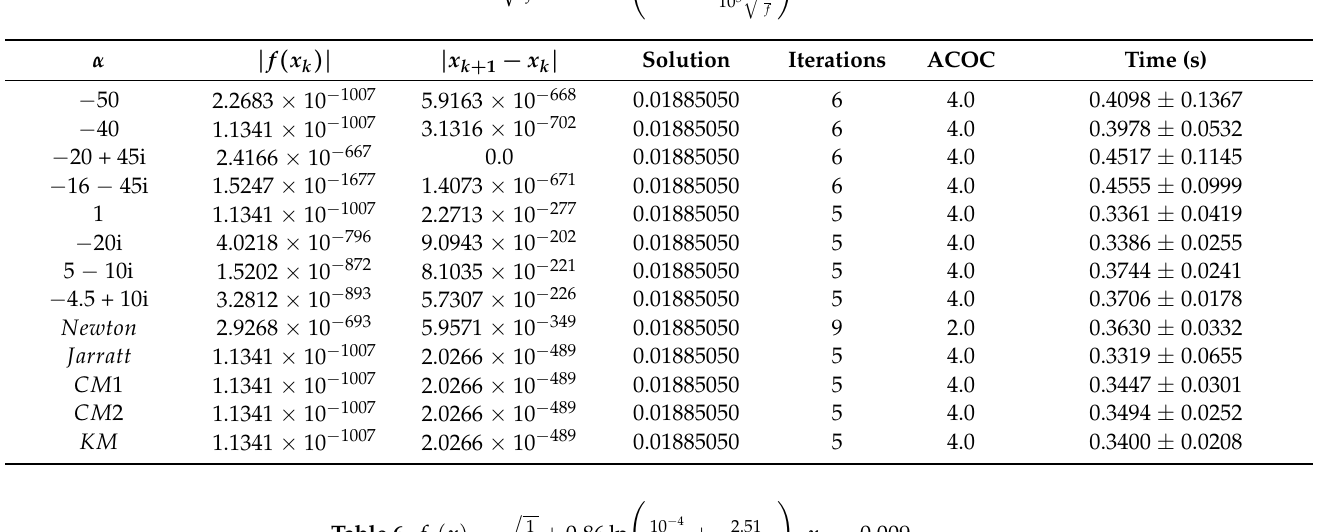
(cid:113) 1 + 0.86ln f